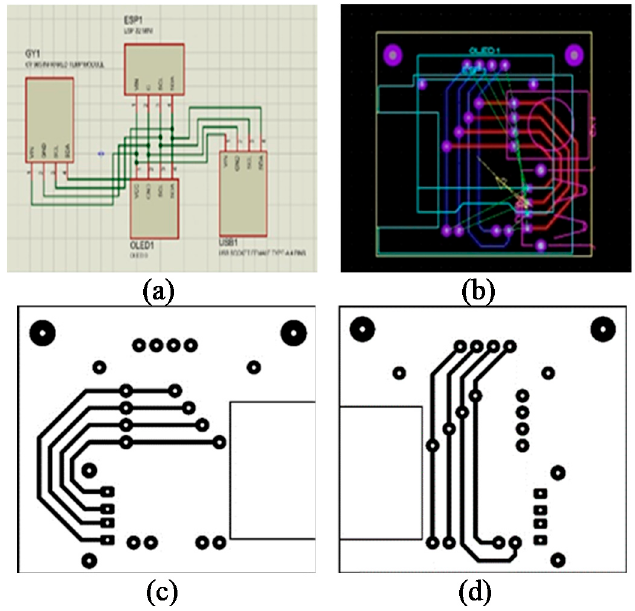
Micromachines 2021 , 12 , 918 Figure 7. Assembling a smart device ( a – d ) the PCB circuit design by the Proteus software.